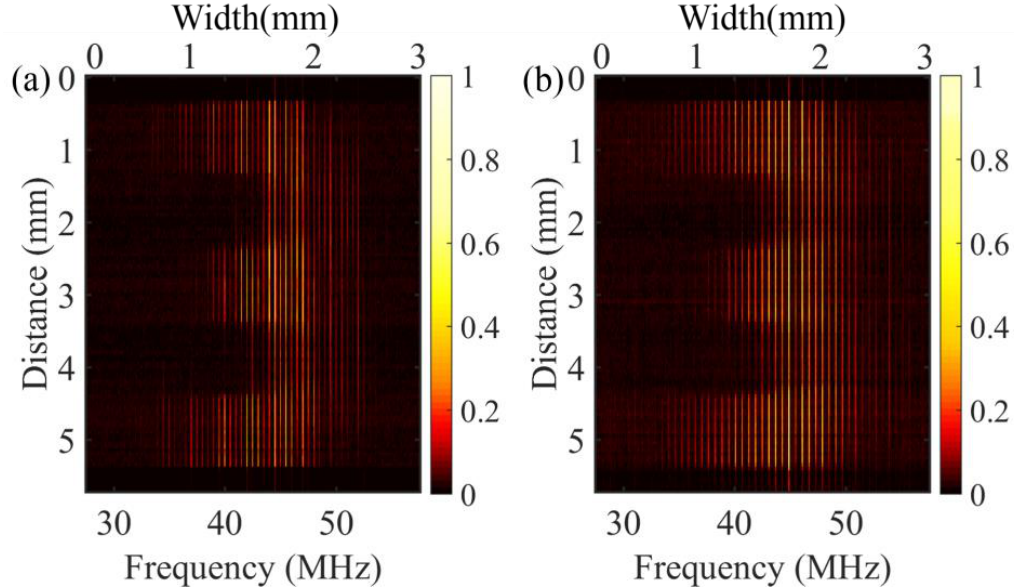
Figure 4. Two-dimensional photon-counting dual-comb interferogram of the target detected with an SNSPD ( a ) and an InGaAs-APD single-photon detector ( b ).